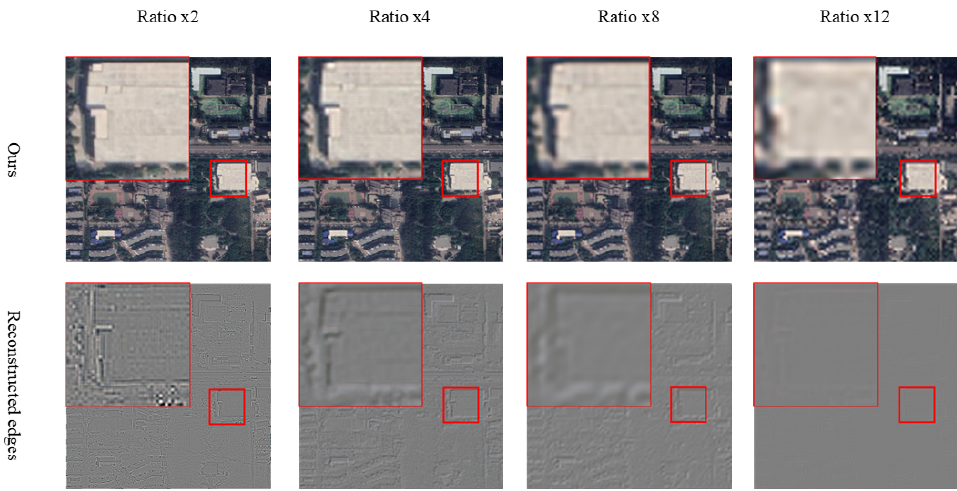
Figure 8. Qualitative assessment of the improvements contributed by the enhancement module with scale ratios of 2 (column I), 4 (column II), 8 (column III), and 12 (column